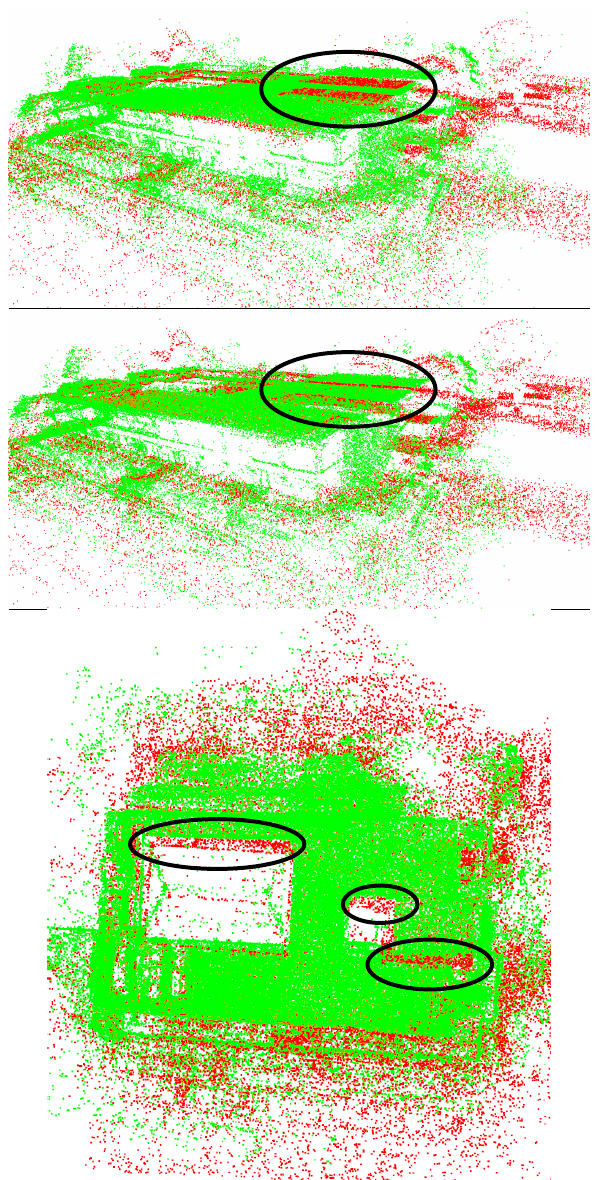
Figure 3. Result of the initial alignment (top) and the local regis- tration with ICP (middle and bottom). Comparing top and middle view, the offset is significantly smaller after employing ICP,